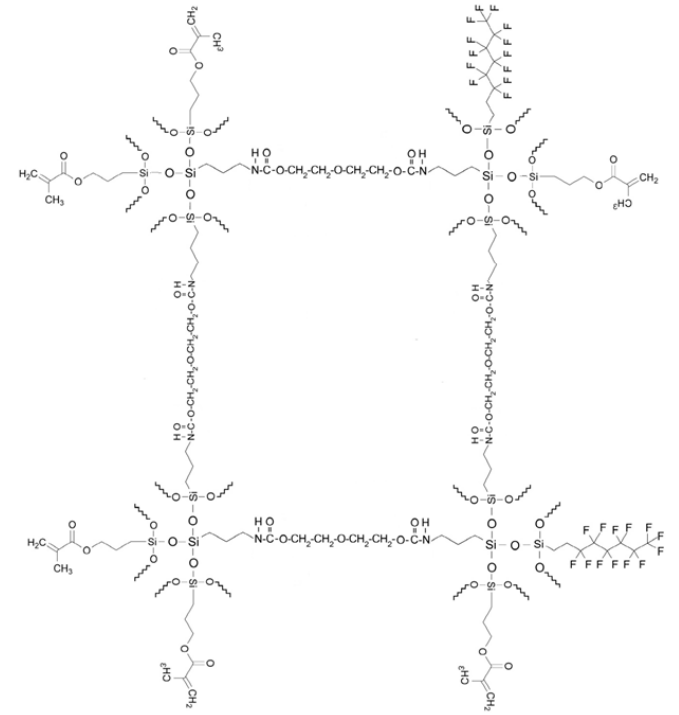
Figure 1. Schematic representation of silane ‐ terminated diethylene glycol (STDEG) modified by both 1H,1H,2H,2H ‐ perfluorooctyl triethoxysilane (PTES) and 3 ‐ (trimethoxysilyl)propyl methacrylate (MEMO).